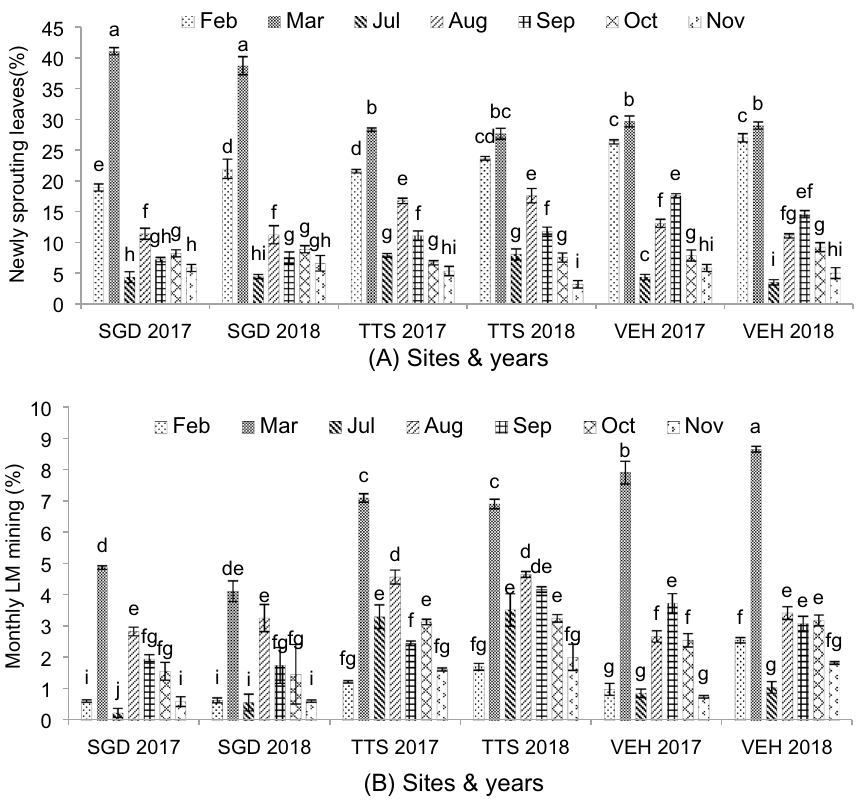
Figure 2. ( A ) Monthly newly sprouted leaves ( B ) Monthly leafminer mining on newly sprouted leaves. Bars sharing dissimilar letters are significantly differed according to LSD test ( P ≤